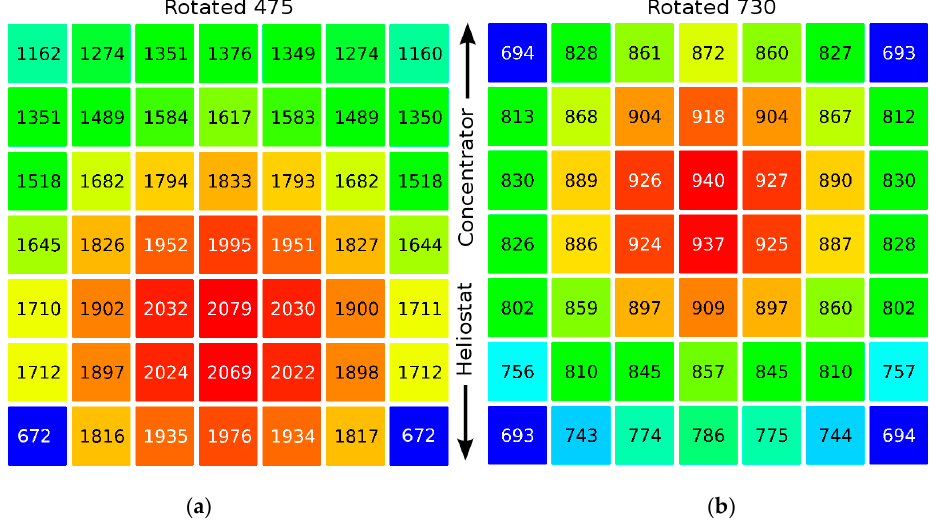
Figure 9. Energy flux (in kW / m 2 ) calculated for a 13.2 ◦ rotated beam, for planes z = 475 mm ( a ) and z = 730 mm ( b ) below the concentrator axis (shifted 120 mm below), using a relative colour scale, from blue (cold) to red (hot). The x axis is horizontal. The vertical y direction is aligned with the paraboloid axis, pointing above ( + y) to the paraboloid concentrator, and below ( − y) to the heliostat.